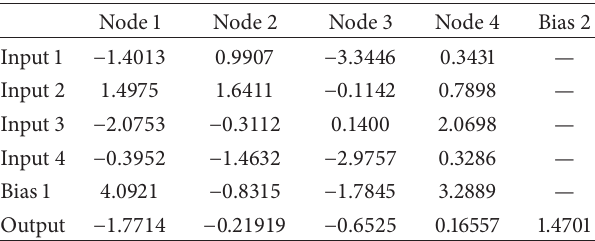
Table 3: Performance evaluation of interactions of input variables for the LM with 4 neurons in the hidden layer for sensitivity